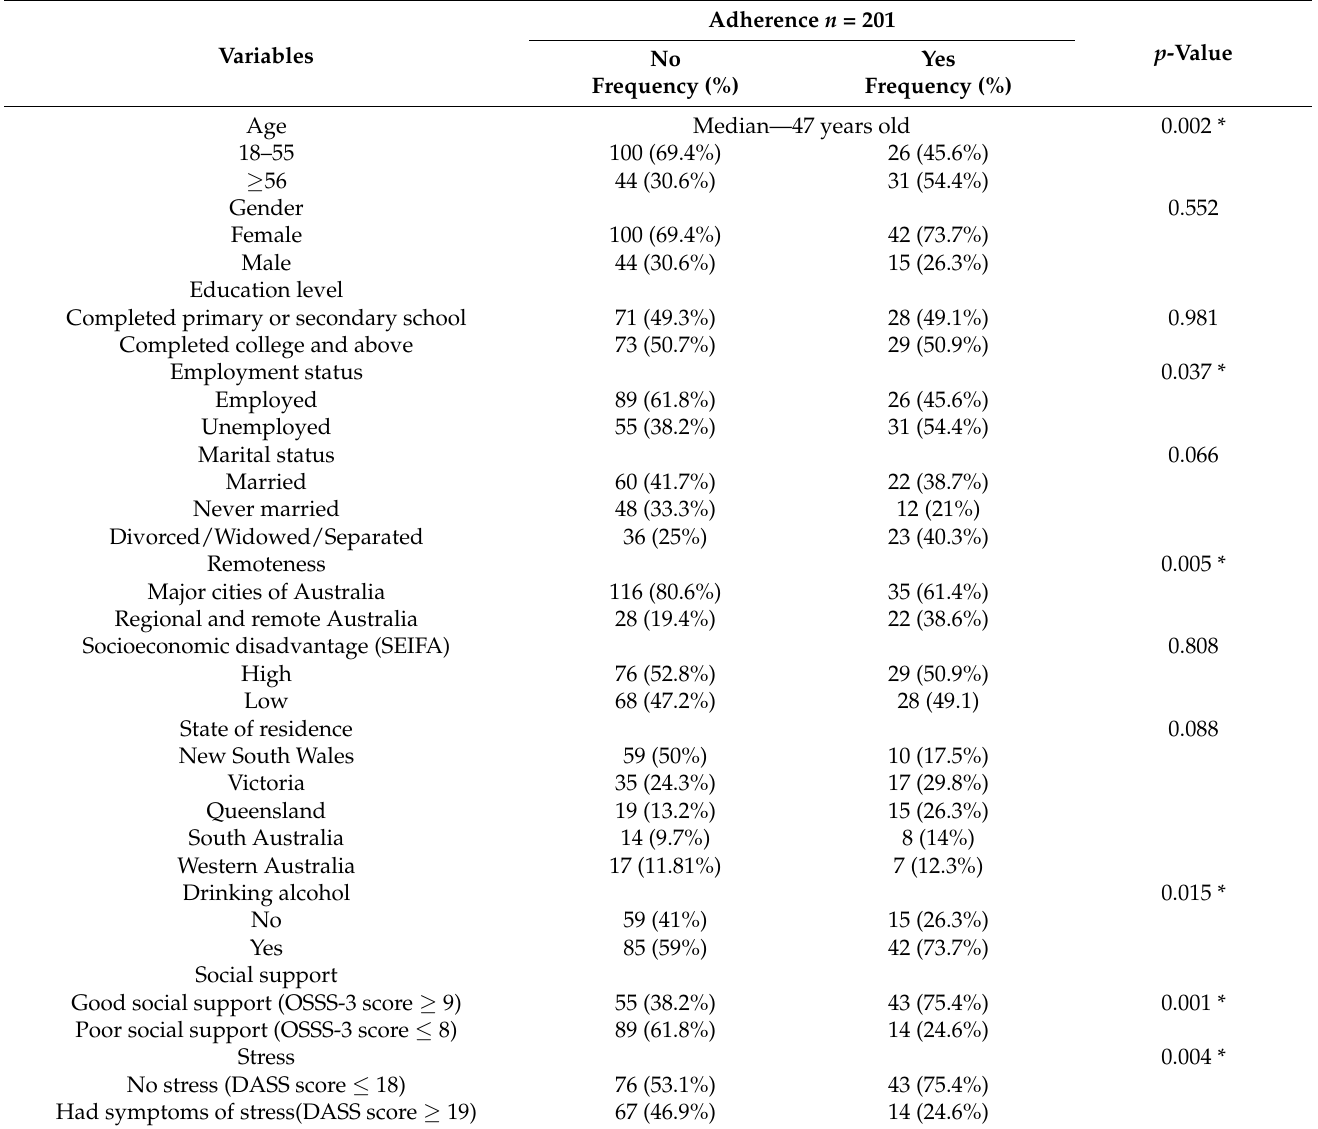
Table 1. Psycho-social and demographic characteristics of participants ( n =